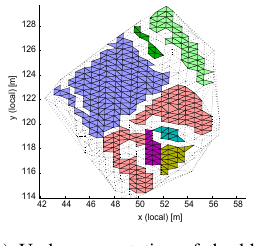
(a) Undersegmentation of the blue seg- ment. Opposite the dark green segment, a similar separate roof part should have been segmented.